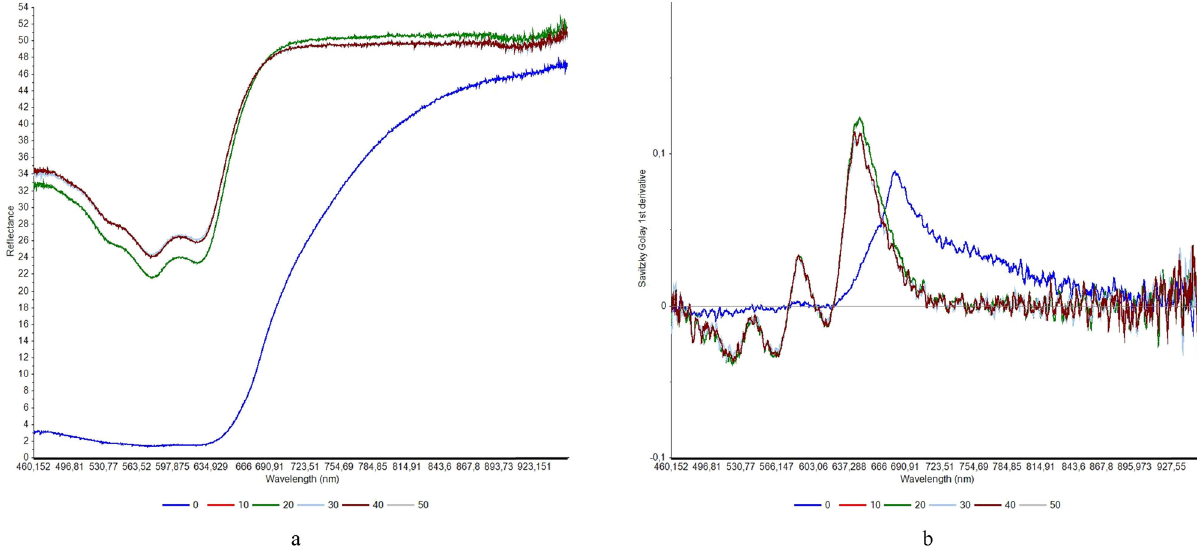
Figure 2: ( a ) Original and ( b ) Savitzky - Golay fi rst - derivative spectra of pure and maltodextrin - added butter fl y - pea extract powder.